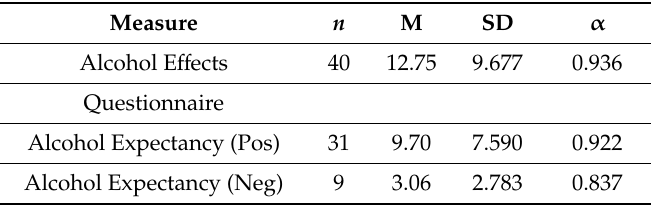
Table 4. Summary of the Alcohol E ff ects